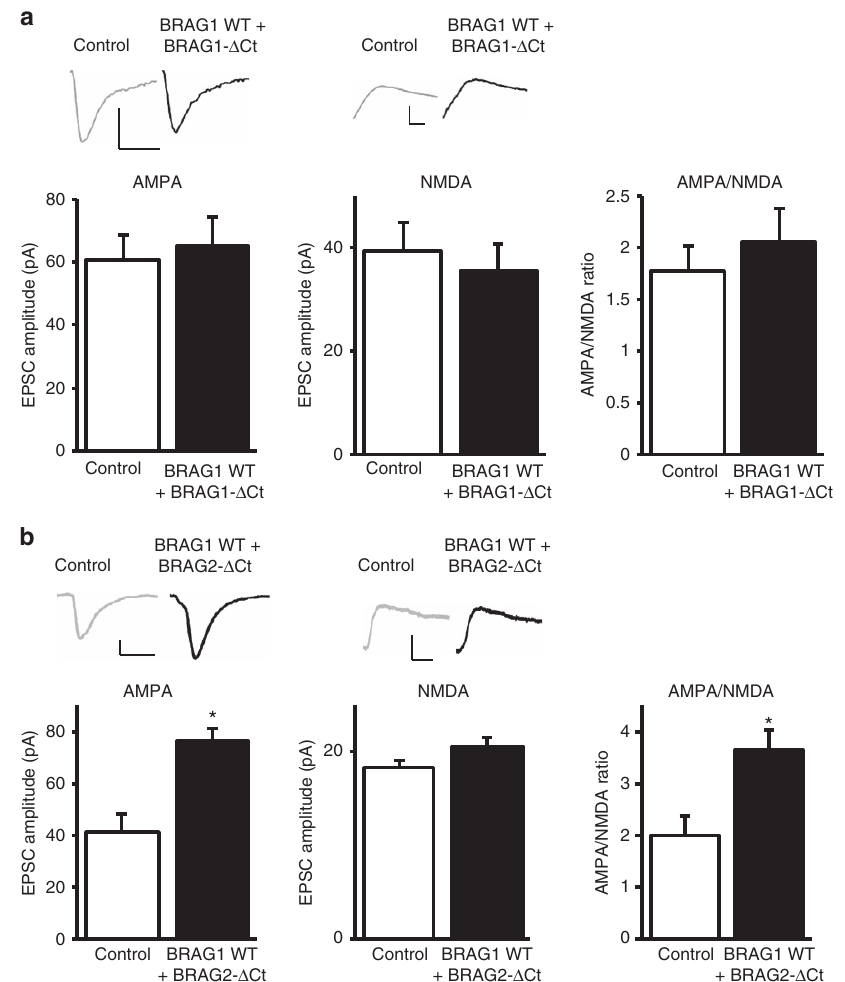
Figure 3 | Expression of BRAG1, but not BRAG2, lacking the PDZ-binding sequence interfere with BRAG1-mediated enhancement of synaptic transmission. ( a , b ) Insets: sample traces of AMPAR- and NMDAR-mediated responses recorded at (cid:2) 60 and þ 40mv, respectively. Scale bars, 20pA, 20ms. Data represent averaged evoked EPSCs recorded for AMPA (left graphs), NMDA (centre graphs) and AMPA/NMDA ratios (right graphs) simultaneously from pairs of untransfected (control) CA1 neurons and neurons transfected with BRAG1 þ BRAG1- D Ct ( a ; AMPA: n ¼ 11, P ¼ 0.65; NMDA: n ¼ 11, P ¼ 0.34; AMPA/NMDA: n ¼ 11, P ¼ 0.08) or BRAG1 þ BRAG2- D Ct ( b ; AMPA: n ¼ 8, P ¼ 0.0063; NMDA: n ¼ 8, P ¼ 0.28; AMPA/NMDA: n ¼ 8, P ¼ 0.05). * Indicates significance ( P r